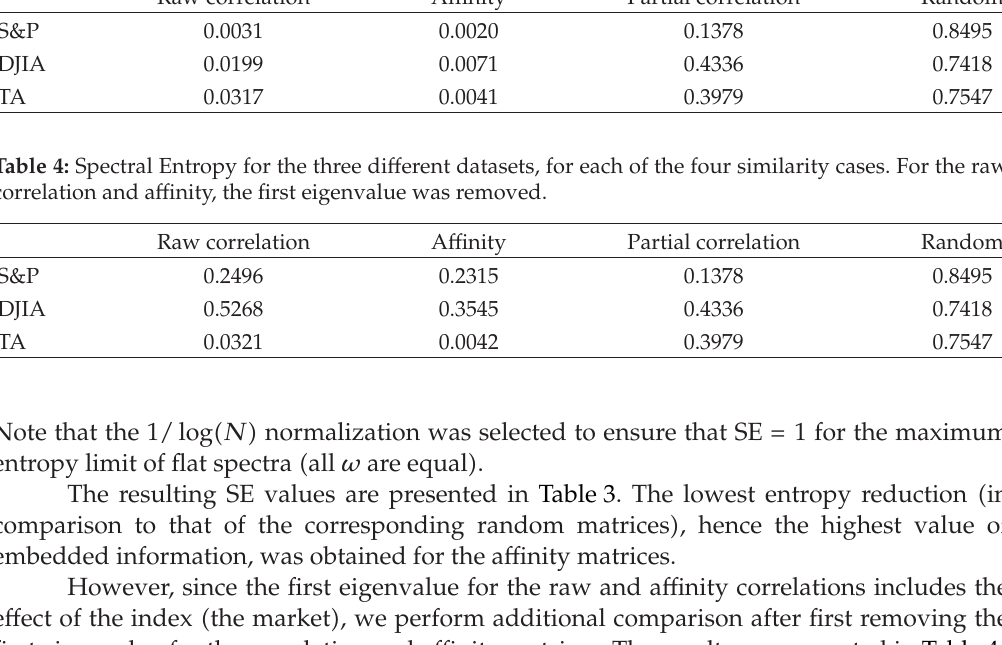
Table 3: Spectral Entropy of for the three di ff erent datasets, for each of the four similarity cases. Raw correlation A ffi nity Partial correlation Random